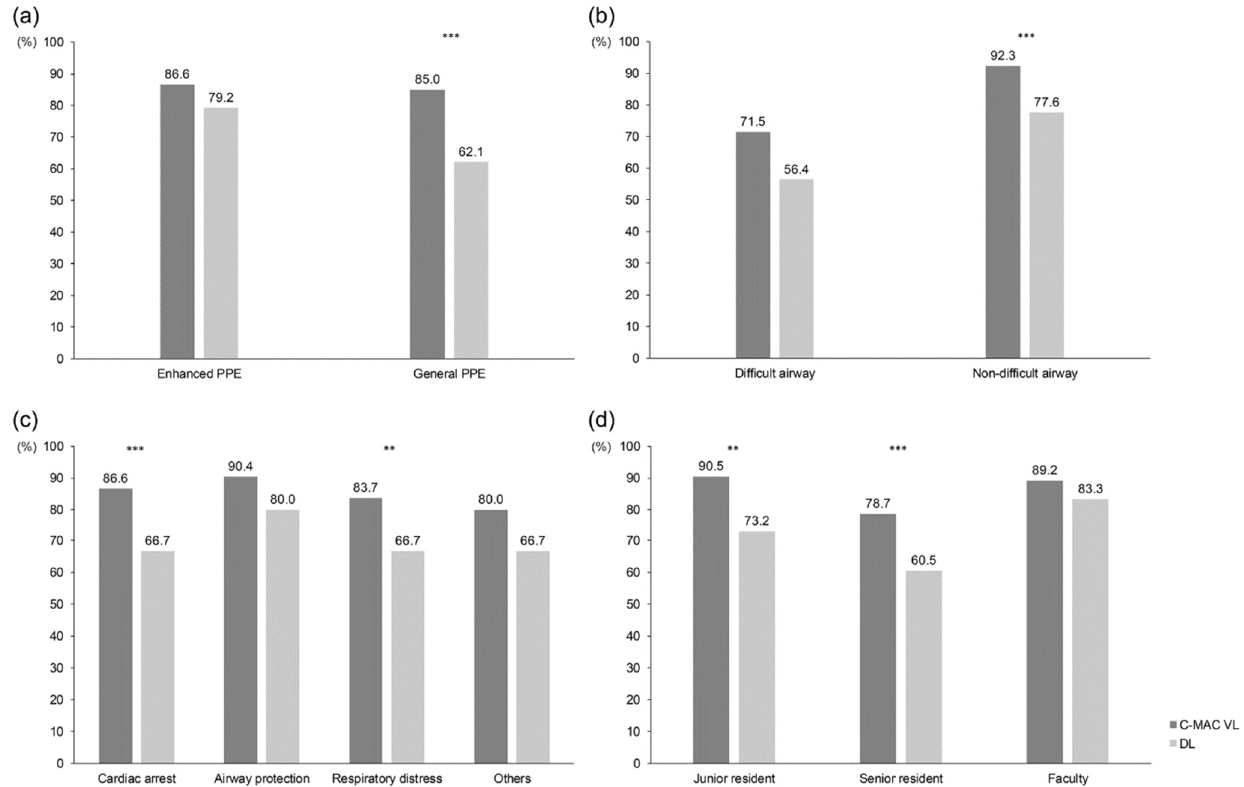
Figure 2. First-pass success rate based on different situations: ( a ) level of PPE; ( b ) anticipated diffi-